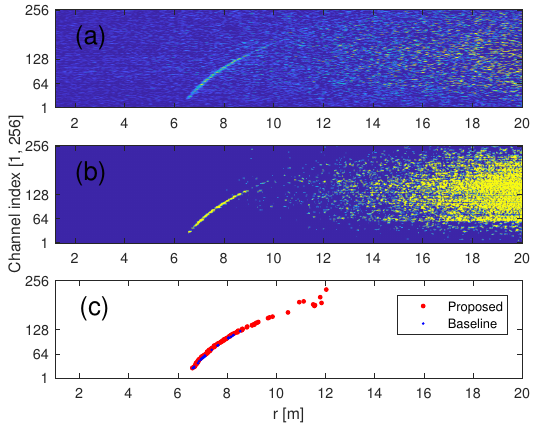
with green lines in Figure 1 (a).